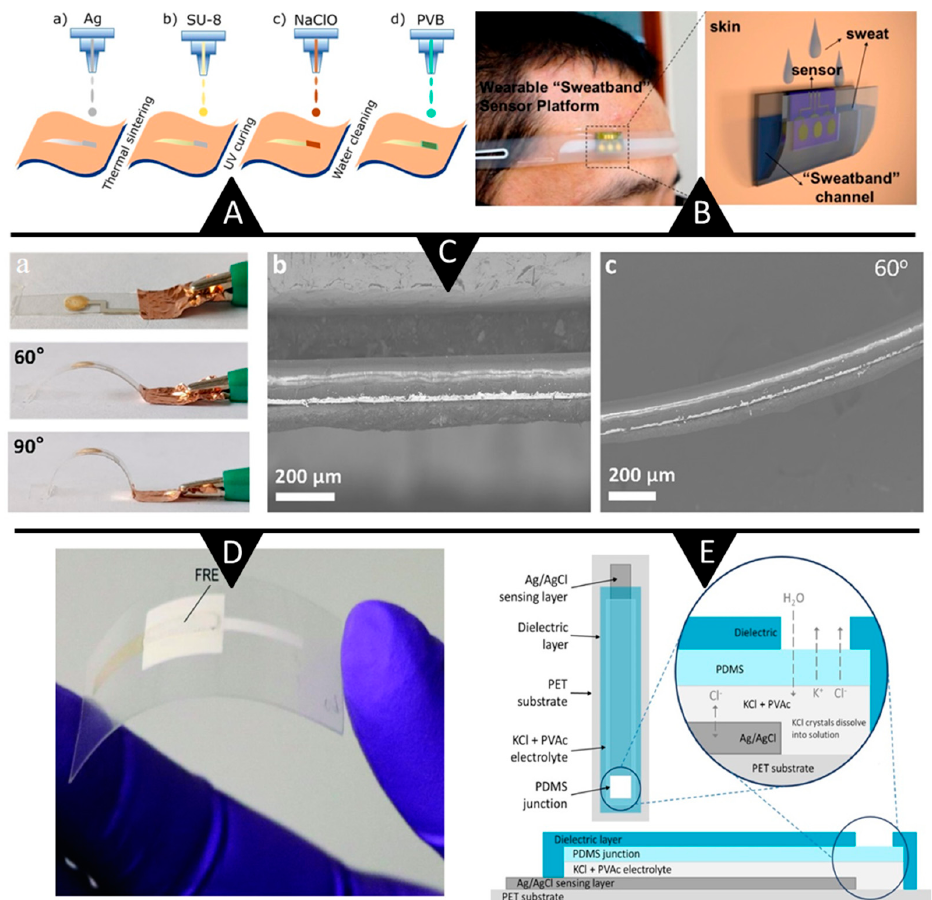
Figure 4. ( A ) Fabrication process of an IJPRE protected by a printable PVB-based membrane [41]. ( B ) Wearable sensor platform based on a solid-state ISE gold nanodendrite electrode and a Ag|AgCl|KCl + PVA membrane-coated RE [44]. ( C ) (a) Photograph of Ag/AgTPB/PVC-TBATPB under no bending and 60 and 90° bending. (b,c) Scanning electronic microscopy images of Ag/Ag- TPB/PVC-TBATPB flexible SCRE developed by Gan [38]. ( D ) Image of the as-obtained thick-film Ag|AgCl|KC + MM:BM SCRE reported by Manjakaal [43]. ( E ) Structure and composition of the SPRE proposed by Dawkins et al. [39]. Inset: ionic exchange pathways within the electrode and between the electrode and the analytes. ( A ) Reprinted with permission from [41]. Copyright (2019), American Chemical Society. ( B ) Reprinted with permission from [44]. Copyright (2017), American Chemical Society. ( C ) Reprinted with permission from [38]. Copyright (2022), American Chemical Society. ( D ) Reprinted with permission from [39]. Copyright (2018), WILEY-VCH Verlag GmbH & Co. KGaA, Weinheim. ( E ) Reprinted from [39], Copyright (2021), with permission from Elsevier. Targeting another type of substrate for this sensing platform, Wang et al. [44] devel- oped a wearable solid-state ISE and RE on a miniaturized chip using a gold nanodendrite (AuND) array electrode as the solid contact and a poly(vinyl acetate)/inorganic salt